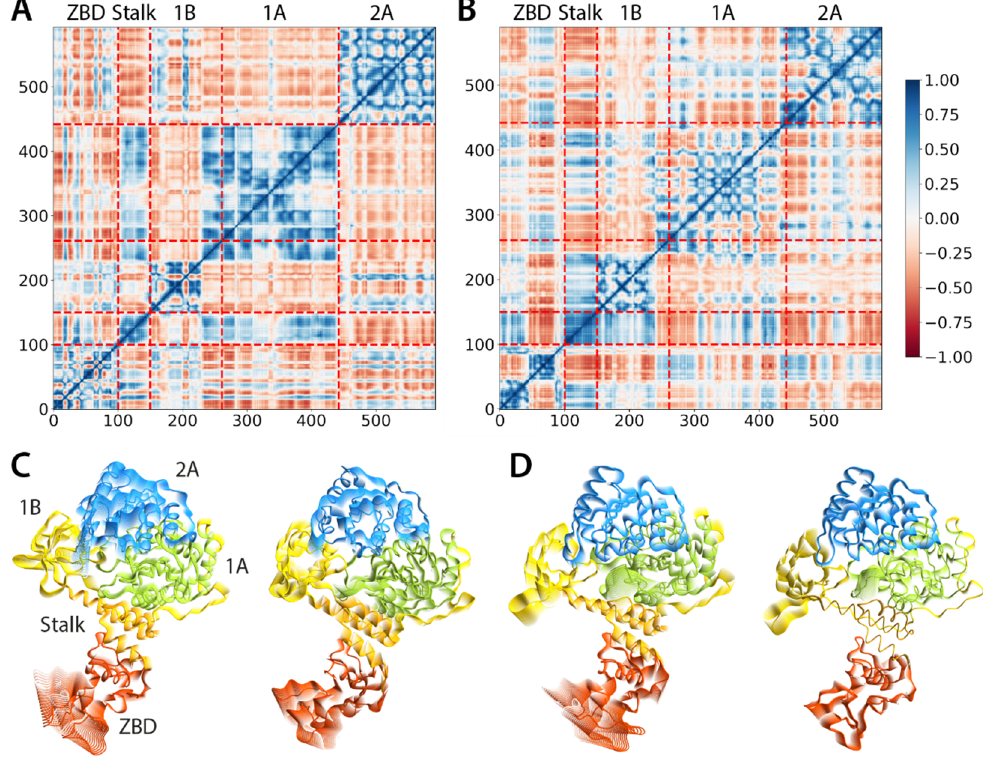
Figure 4. Residue–residue map of the C α covariance maps of RNA-free ( A ) and RNA-engaged ( B ) NSP13. Blue regions show positive correlations, while dark red regions indicate anticorrelations. The red dashed lines indicate the border between subsequent domains. The bottom panels report the structural variations occurring in the first two principal components (PC) in RNA-free ( C ) and RNA-engaged ( D ) NSP13. In the bottom panels, NSP13 ribbons are colored as in Figure 1C.